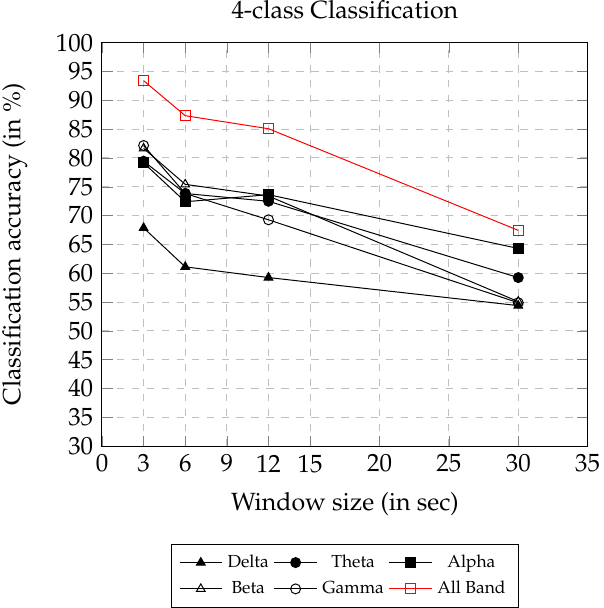
Figure 7. 4-class classification accuracy on varying window size using AsMap+CNN